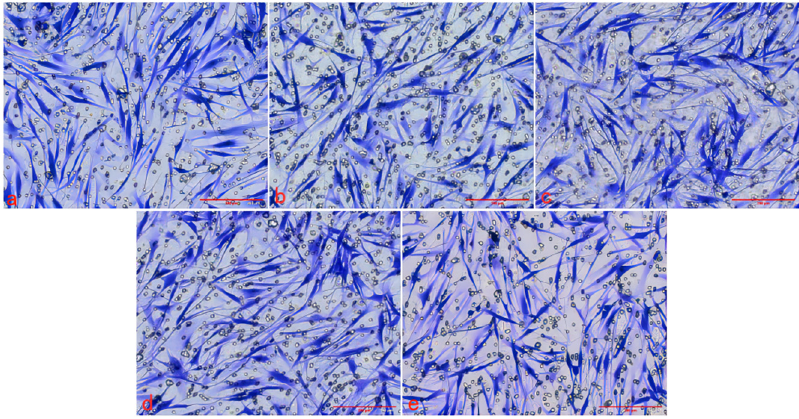
Figure 7. The Transwell cell migration map of HSFs labeled with GOQDs. ( a – e ) are 0 μ g/mL, 50